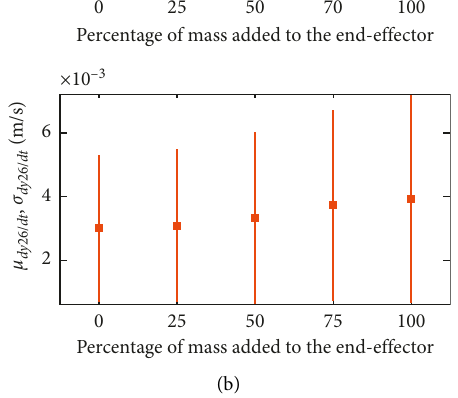
Figure 11: Means (markers) and standard deviations (lines) of the estimation errors on the linear elastic displacements (a) and ve- locities (b) of the end-effector for different values of payload